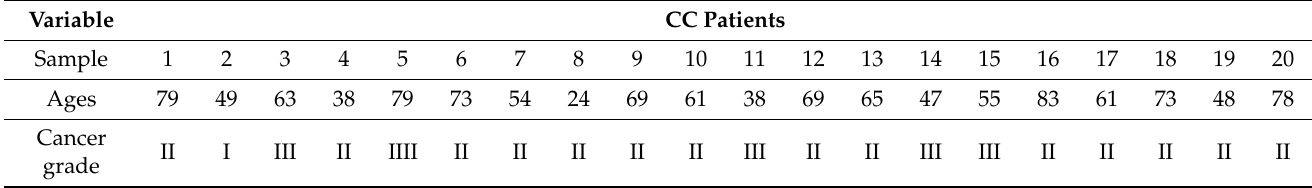
Table 4. Colon cancer (CC) patients’ ages and their cancer grades.